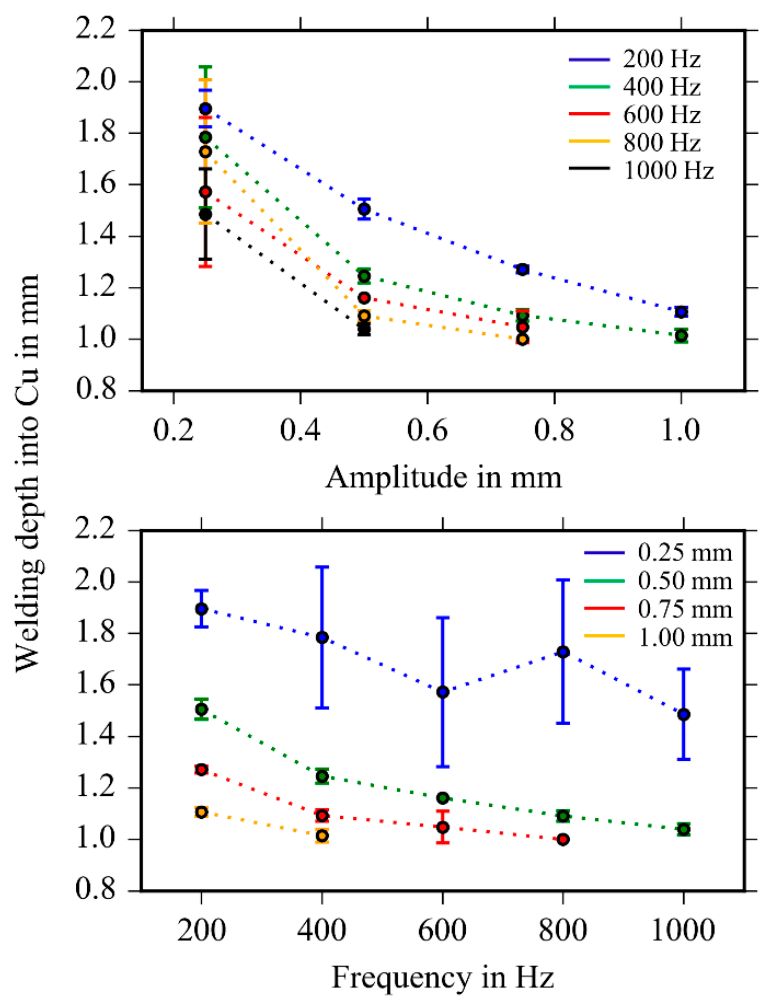
Figure 9. Welding depth into Cu in dependence on the oscillation frequency and amplitude. The error bars indicate the standard deviation.